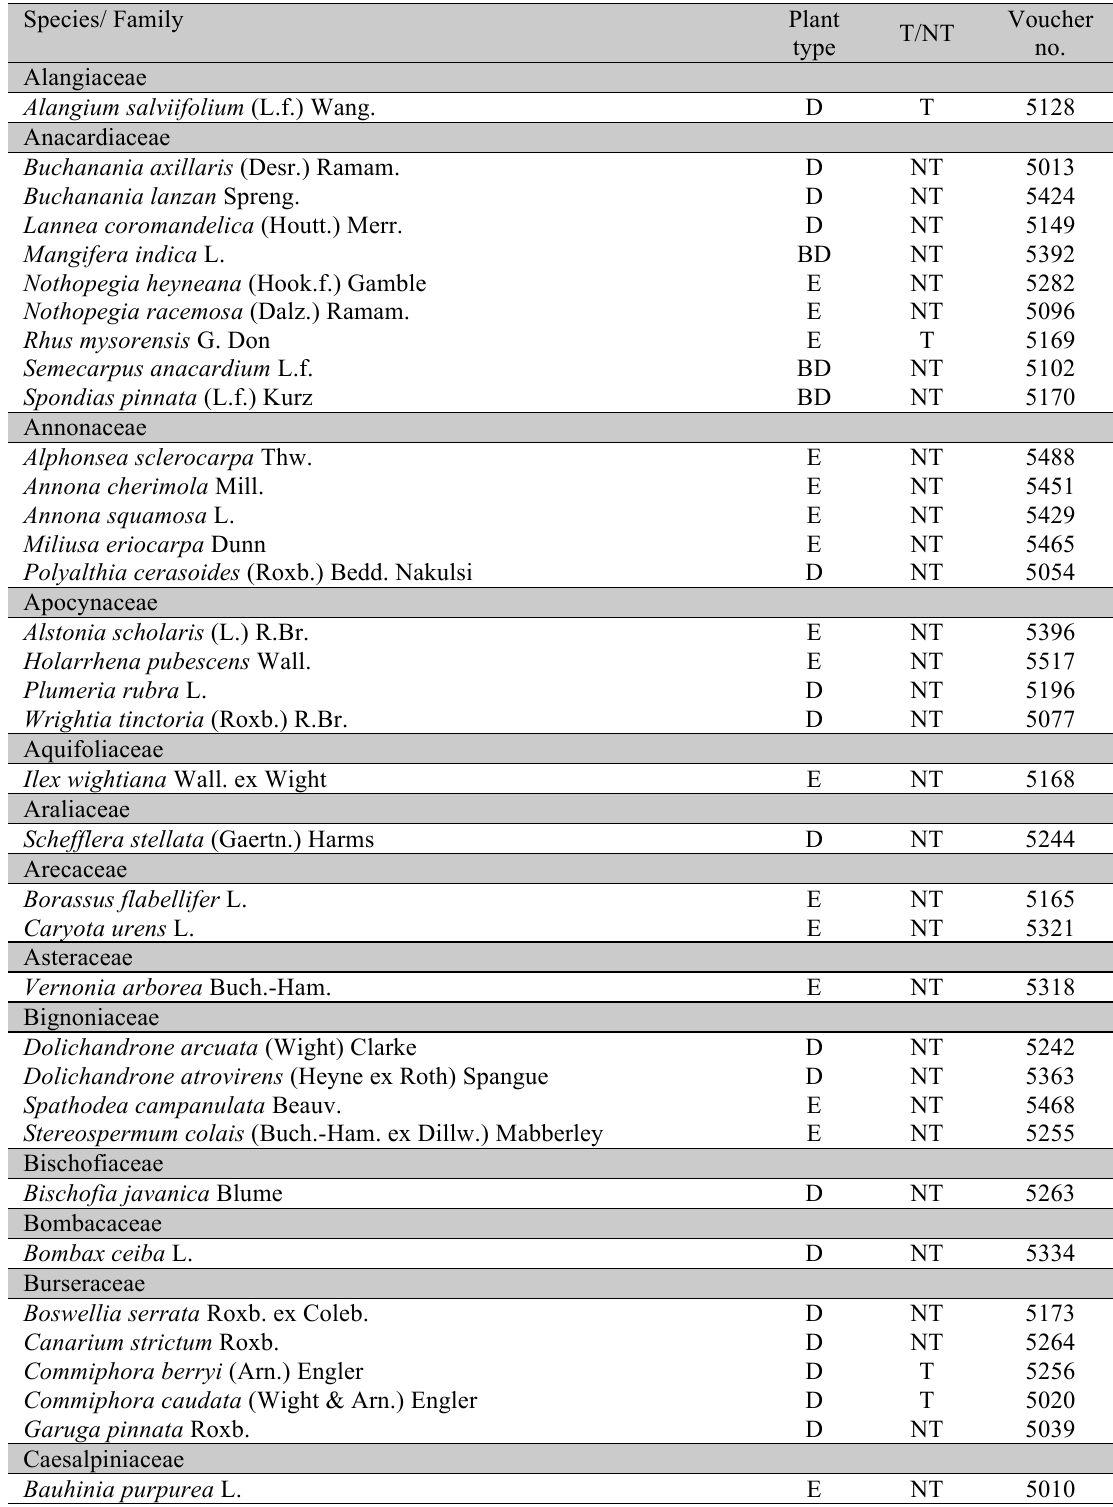
Table 1. Total list of tree species enumerated from 120 belt transects of 0.5 ha area in six hill complexes of southern Eastern Ghats, Tamil Nadu, India. (BD: brevi-deciduous; D: deciduous; E: evergreen; T: thorny;